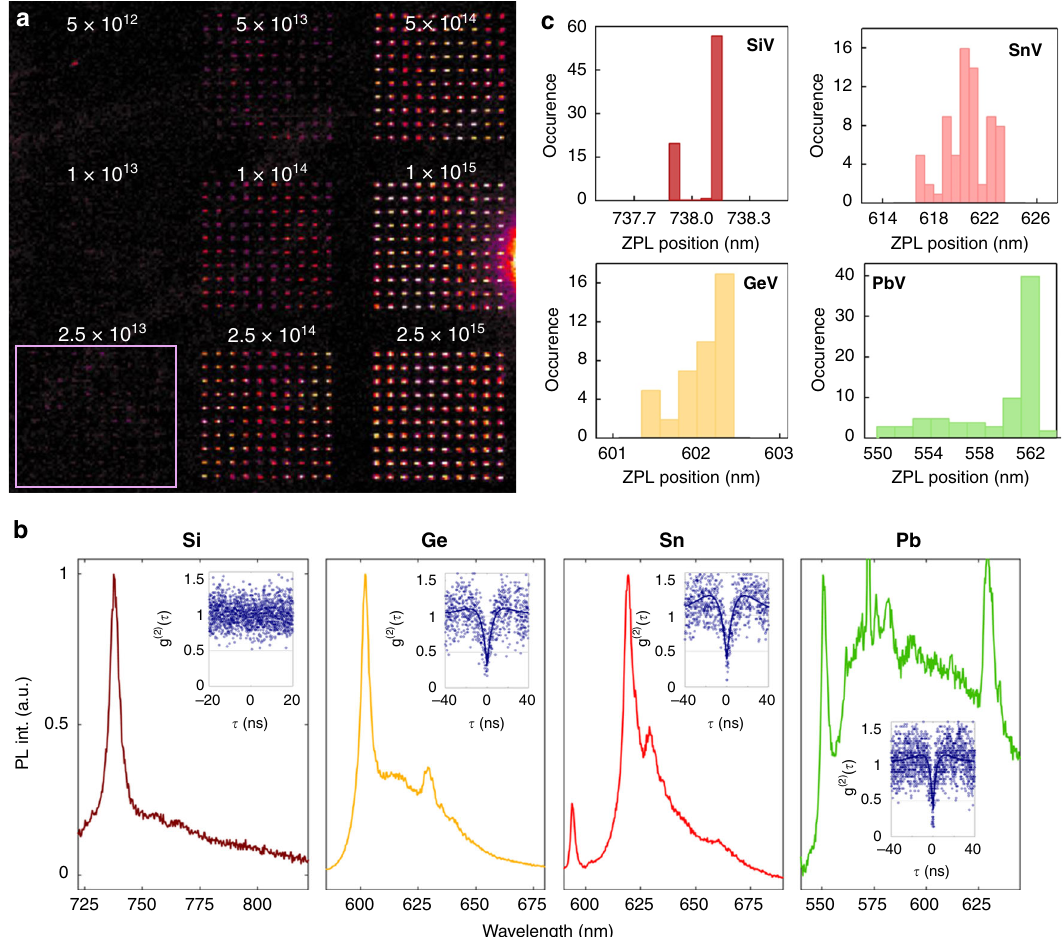
Fig. 2 Spot arrays of dopants implanted into diamond as a function of Xe + fl uence. a Photoluminescence map of a representative array, here shown for Si dopants. The framed area shows the lowest fl uence of Xe + that yielded an unambiguous observable array in this case. The number above each array speci fi es the Xe + fl uence in units of cm − 2 . b Photoluminescence spectra of emitters from the lowest observable fl uence of SiV (maroon), GeV (orange), SnV (red) and PbV-related emissions (green). An additional peak at 630 nm corresponds to the Raman signal of the utilised immersion oil. Insets show second order correlation measurements (background corrected), illustrating the quantum nature of the colour centres. c Histograms showing variability in ZPL wavelength in spot arrays of the colour centre